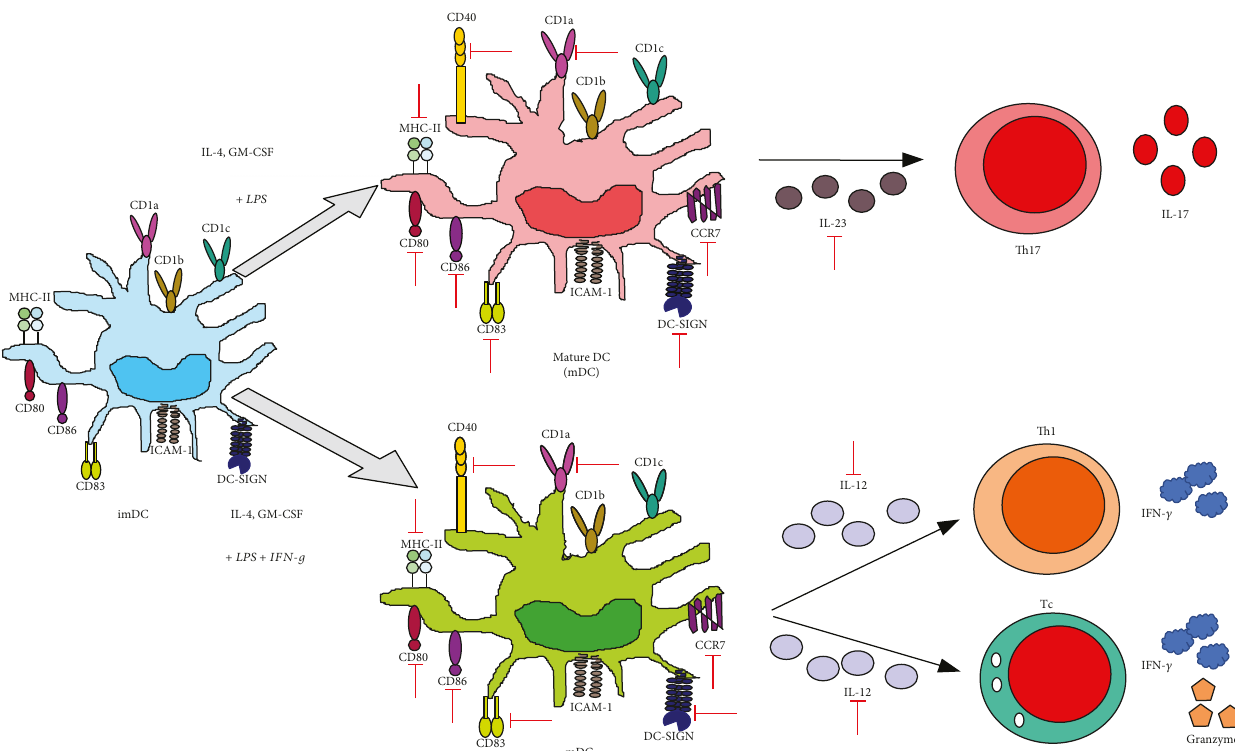
Figure 5: VPA impedes lymphocyte polarization by a ff ecting the production of cytokines by mature DCs. VPA has diverse e ff ects on DC maturation in response to either LPS or LPS+IFN- γ , including the reduction of costimulatory (CD40, CD80, CD83, and CD86), MHC-II (HLA-DR), adhesion (DC-SIGN), CD1a, and CCR7 (CCL19 receptor) molecules, which impedes chemotaxis of such cells, as well as IL-23 and IL-12 secretion, promoting Th17 or Th1 polarization, respectively. Green arrows indicate the processes, molecules, or mediators in the signaling pathway that are augmented and/or promoted by VPA. Red arrows indicate processes, molecules, or mediators in the signaling pathway that are inhibited by